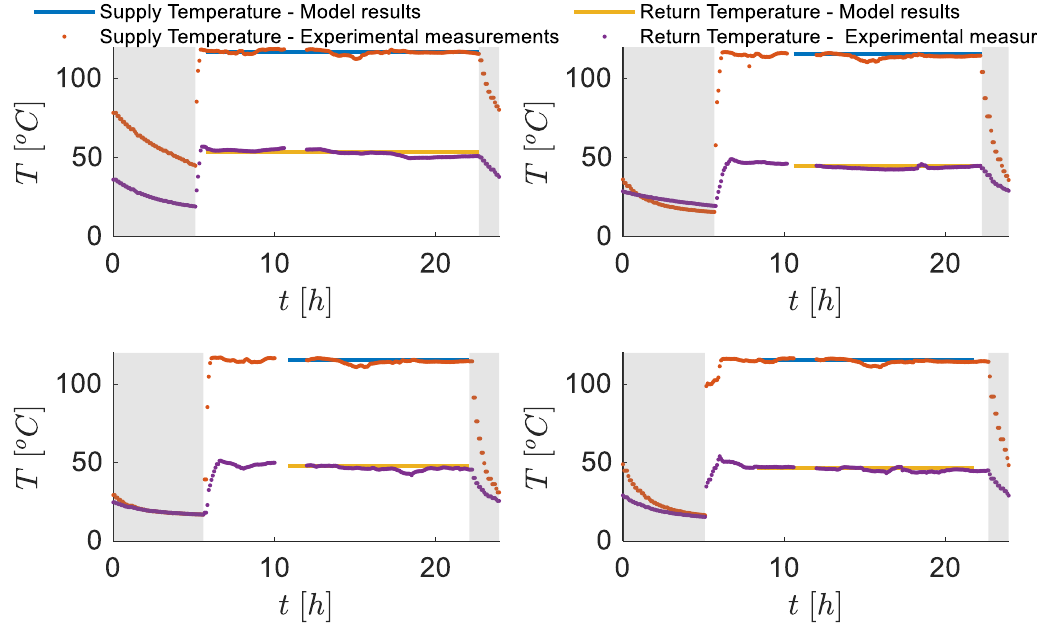
Figure 2. Comparison of experimental measurements and model results for the supply and return temperature of four different substations belonging to different buildings of a small-scale DH network located in Italy. Shaded areas refer to off-conditions in which experimental measurements are not significant.